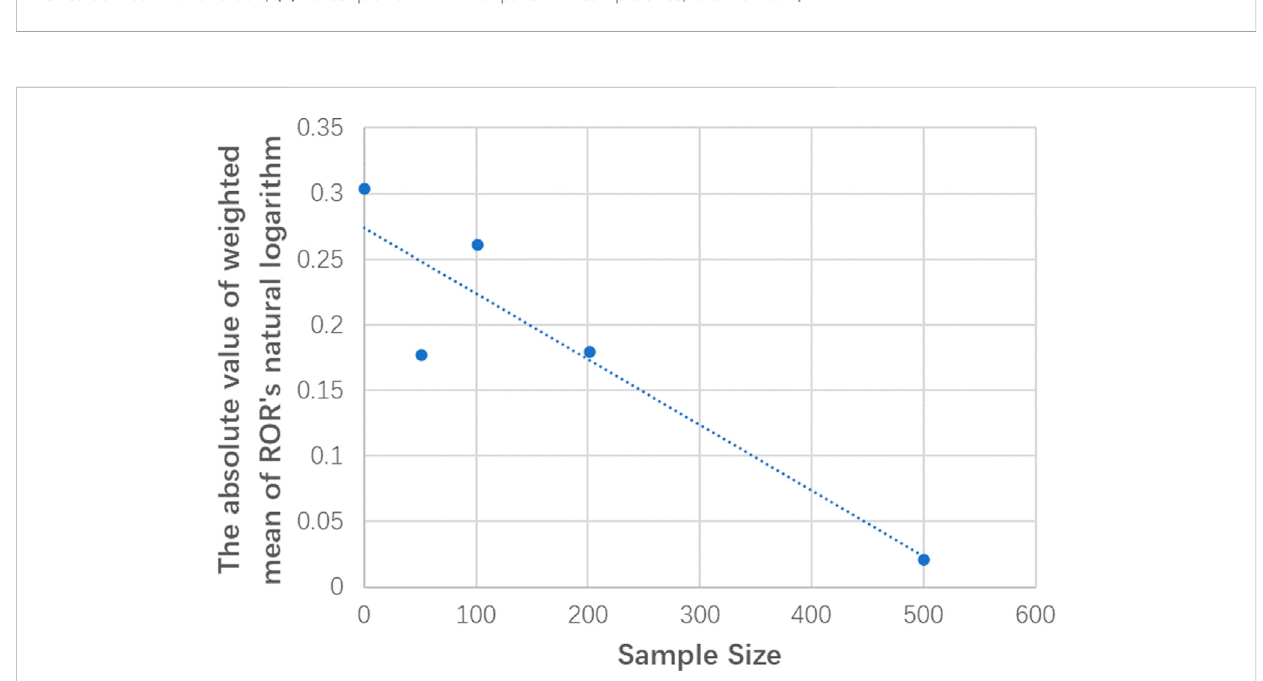
Scatter plot between the sample size and the absolute value of the weighted mean